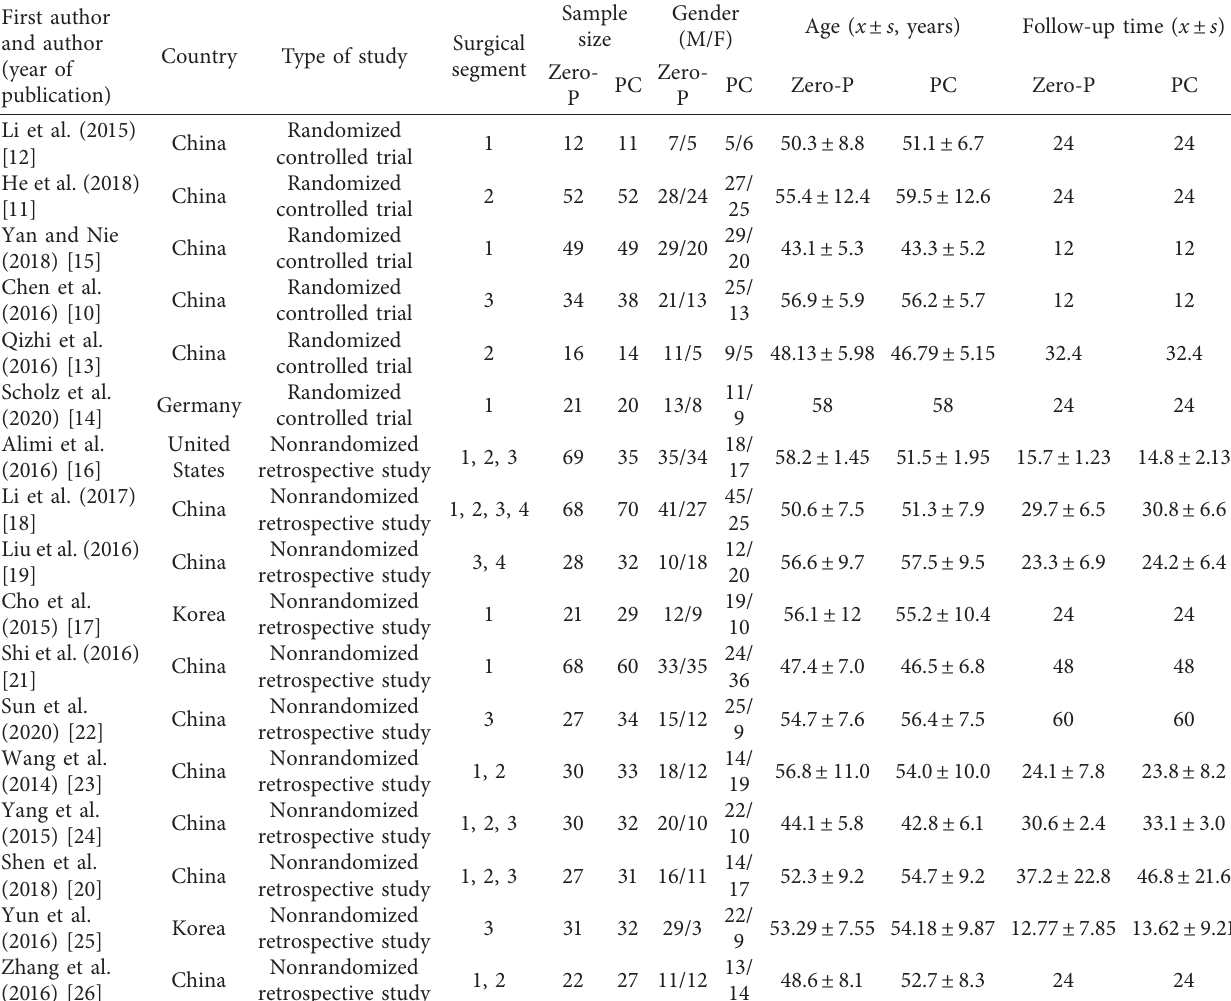
Table 1: Quality evaluation of